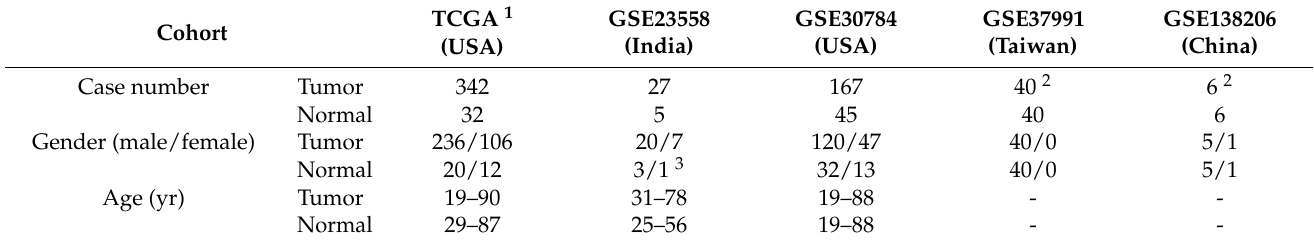
Table 1. The 5 oral cancer data sets used for gene set enrichment analysis.